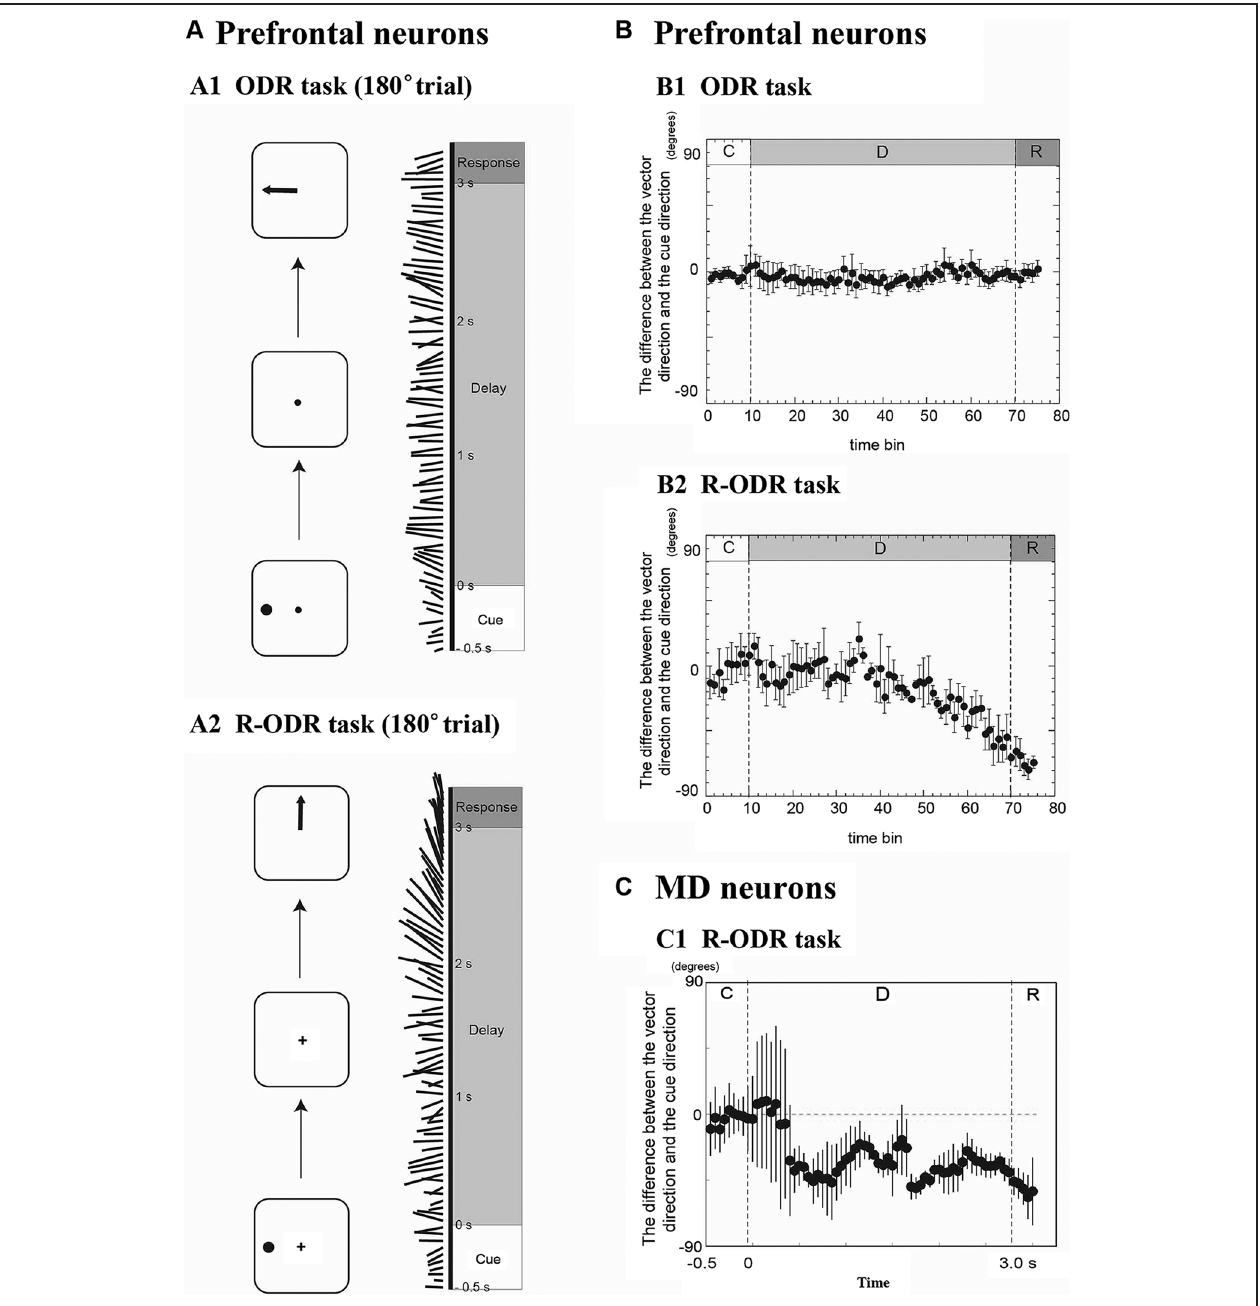
direction during the R-ODR trial. The direction of the population vector gradually rotated from the cue direction to the saccade direction during the delay period. The timing of the change was start at 1.5 s after the start of the delay period (adapted from Takeda and Funahashi (2004)). (C1) Temporal changes in the differences between the directions of population vectors and the direction of the visual cue in the R-ODR task for MD neurons. The direction of the population vector rotated from the cue direction to the saccade direction during the delay period, similar as prefrontal neurons. However, the timing of the change was start at 0.5 s after the start of the delay period (Adapted from Watanabe et al.